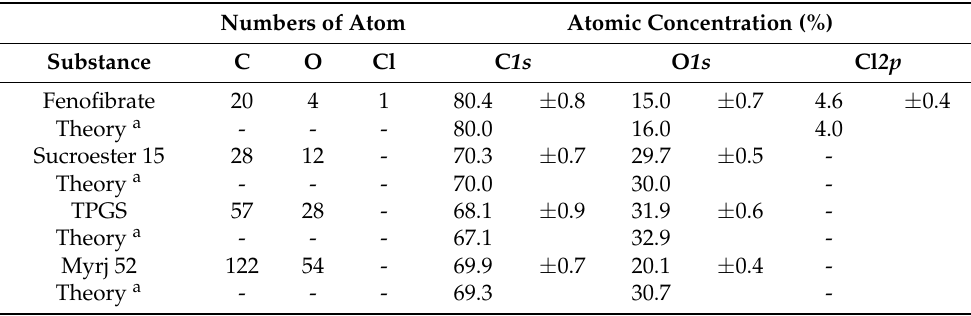
Table 3. Atomic concentrations (%) determined by the XPS and theoretical values for the additives used for preparing the fenofibrate microparticles (mean ± S.D., n = 3).